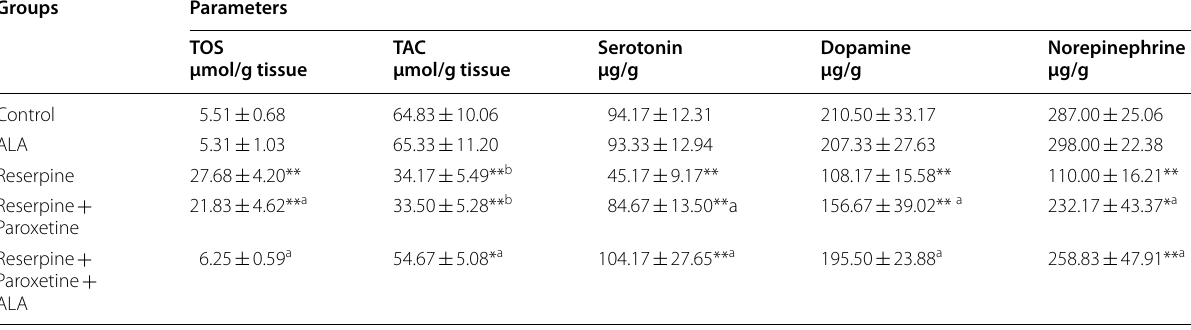
Table 2 Effect of different treatments on the levels of brains TOS, TAC, serotonin, dopamine and norepinephrine in the different experimental